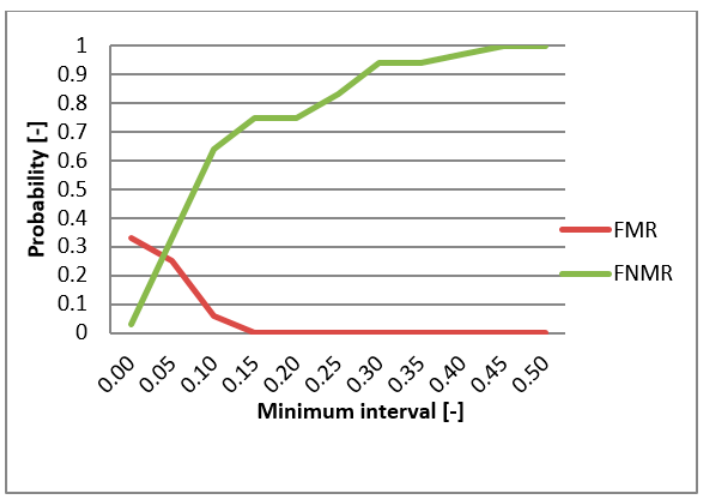
Figure 15. EER for Hamming distance.